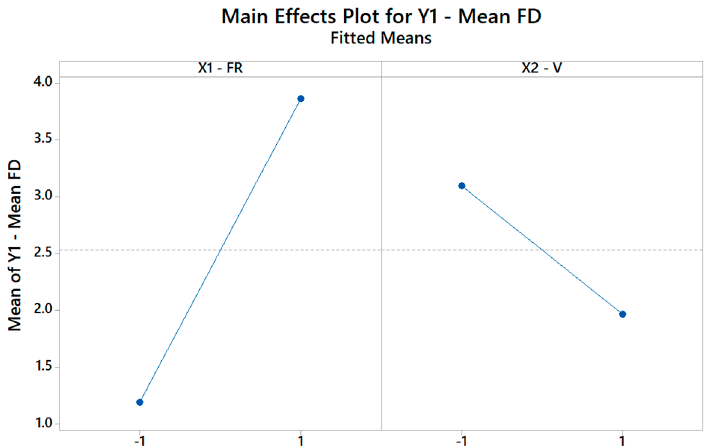
Figure 8. The main effects plot for the FD plot showing how the model explains the change in mean FD based on the change of the FR and V levels.